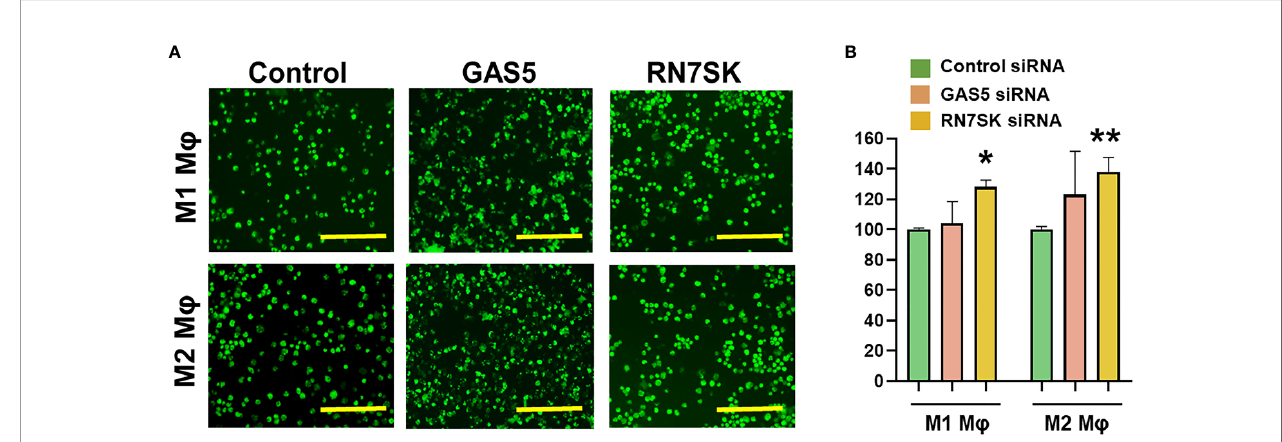
FIGURE 4 | Knockdown of RN7SK augments bacterial phagocytosis in M1 and M2 macrophages. Day 3 M1 or M2 macrophages were transfected with 100 nM siRNA targeting GAS5, RN7SK or scramble. Phagocytosis was assayed using GFP labeled E. coli for 2 h by imaging and fl ow cytometry. (A) Representative images showing phagocytosed bacteria (green) in M1 and M2 macrophages transfected with lncRNA or control siRNA. Images were captured using fl uorescent microscope. Scale bar — 200 µm. (B) Cells harvested after phagocytosis assay and quantitative differences in phagocytic ef fi ciency were measured. Geometric Mean Fluorescent intensity (Geo. MFI) of phagocytosed green E. coli in M1 and M2 macrophages was calculated for GAS5, RN7SK or control siRNA and percent changes were calculated with respect to control. Each bar is representative of at least three different experiments and represents the mean ± standard deviation. Two-tailed t-test was used to evaluate statistical signi fi cance ( *P < 0.05, **P < 0.01